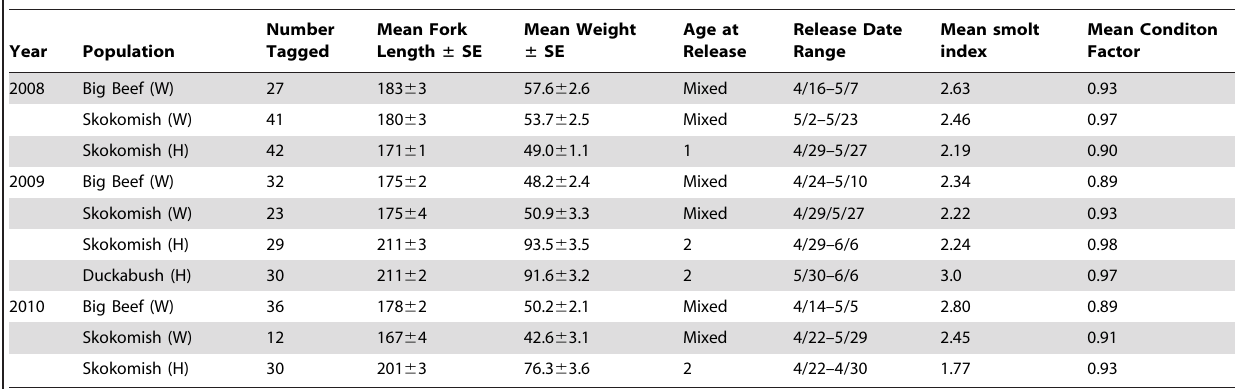
Table 1. Tagged steelhead smolt physical parameters.